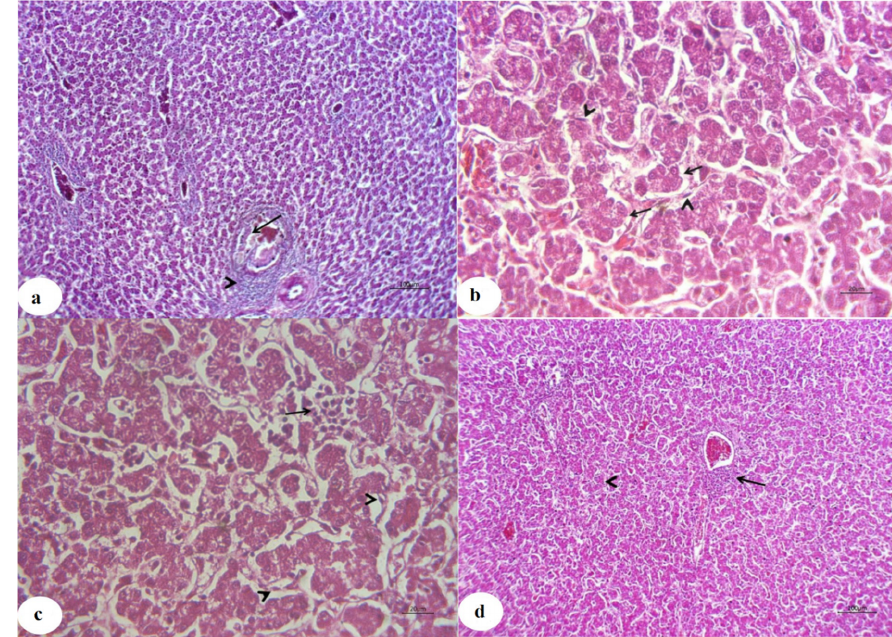
Figure 4. Photomicrographs of liver sections for chickens of all experimental groups at the end of the 6th week. ( a ): Liver of CuSO 4 -intoxicated chicken showed cholestasis, necrotic bile duct epithelia (arrow), besides portal lymphocytic aggregation and fibroblast proliferation (arrowhead). ( b ): Liver of CuSO 4 + Vit. C supplemented chicken showed partially contracted hepatic cells (arrow), proliferative Kupffer cells, and dilated sinusoids (arrowhead). ( c ): Liver of CuSO 4 + Vit. E supplemented chicken showed intense hyperplasia of Kupffer cells (arrowhead) and cloudy swelling of hepatic cells with a few lymphocytic aggregations (arrow). ( d ): Liver of CuSO 4 + Vit. C + Vit. E supplemented chicken showed mild portal lymphocytic aggregation (arrow) and normal hepatic parenchyma (arrowhead) with dilated blood vessels.